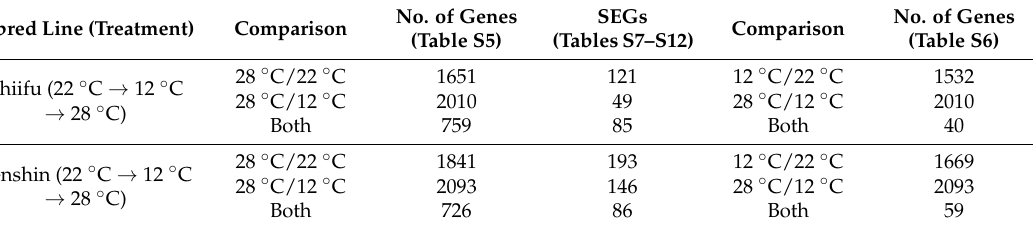
15 HSP s and chaperone genes (Table S14). We subjected the genes listed in Tables S12–S14 to further GO enrichment analysis (Tables 2–4). Table 1. Summary of genes upregulated by various treatments. SEGs (specifically expressed genes) represent genes showing an over 2-fold change in expression under the indicated condition but no change or downregulation under the other conditions.